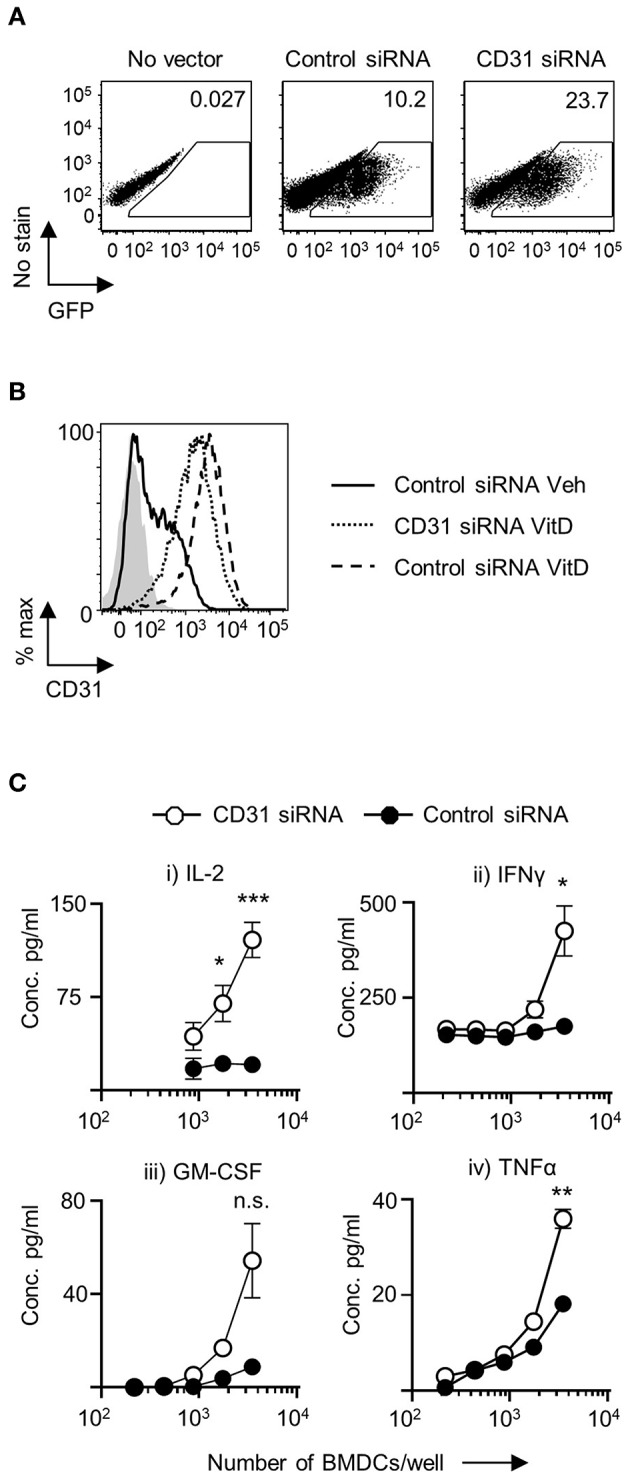
Downregulation of CD31 in VitD BMDC results in enhanced in vitro priming of CD4+ T cells. Bone marrow derived dendritic cells (BMDC) were generated over 9 days with 20 ng/ml GM-CSF in the presence (VitD) or absence (Veh) of 20 nM 1,25(OH)2D3. On day 6, BMDC were transduced with indicated lentiviral constructs, all expressing GFP. (A) Representative flow plots of transduction efficiency as determined by GFP expression, utilized for flow cytometric sorting of transduced cells for downstream analysis. (B) Representative flow plot of CD31 protein expression in VitD CD11c+BMDC transduced with a lentiviral vector containing CD31 siRNA (dotted line) compared to VitD and Veh CD11c+BMDC transduced with a lentiviral vector containing control siRNA (dashed line and continuous line, respectively). Isotype control is indicated by gray shaded area. (C) VitD CD11c+BMDC transduced with control siRNA (black) or CD31 siRNA expressing (white) lentiviral vector were matured in the presence of 0.1 μg/ml LPS for 4 h and pulsed with 0.1 μg/ml 4Y peptide, and were subsequently co-cultured at indicated cell numbers with 2 × 104 Tg4 CD4+ T cells for 48 h (IL-2) or 72 h (all other cytokines). Cytokine release was assessed by ELISA. n = 3, representative of 2 experiments (*p < 0.05, **p < 0.01, and ***p < 0.001).